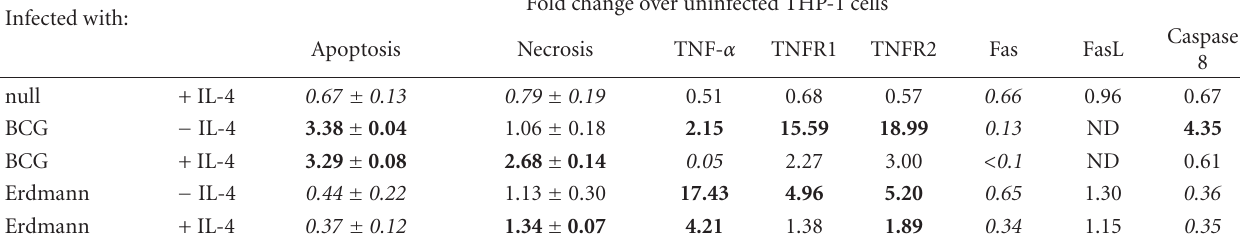
Table 1: Alteration in cell death by apoptosis or necrosis in THP-1 cells infected with BCG or M. tuberculosis Erdmann (MOI 50) assessed at 24 hours by the Cell Death Detection ELISA PLUS photometric enzyme immunoassay (Roche Diagnostics, Lewes, UK) which measures cell death by both apoptosis and necrosis on fractionated samples. Associated changes in mRNA for the major host genes involved in the activation of the extrinsic pathway of apoptosis were assessed by quantitative Real-Time PCR, using HuPO as a housekeeping gene for normalization. Results shown are relative to untreated cells, of the means of assays from a single experiment (representative of 4) performed in triplicate (ELISA) or quadruplicate (RT-PCR). Values marked in bold text represent a significant increase, those in italics a significant decrease. The ANOVA test (with Dunnett’s multiple comparison posttest for all groups against untreated controls) was used for analyses between groups. In all instances, a P value < . 05 was considered significant. A value of “ < .1” indicates below the limit of detection, with “ND” indicates that the experiment was not